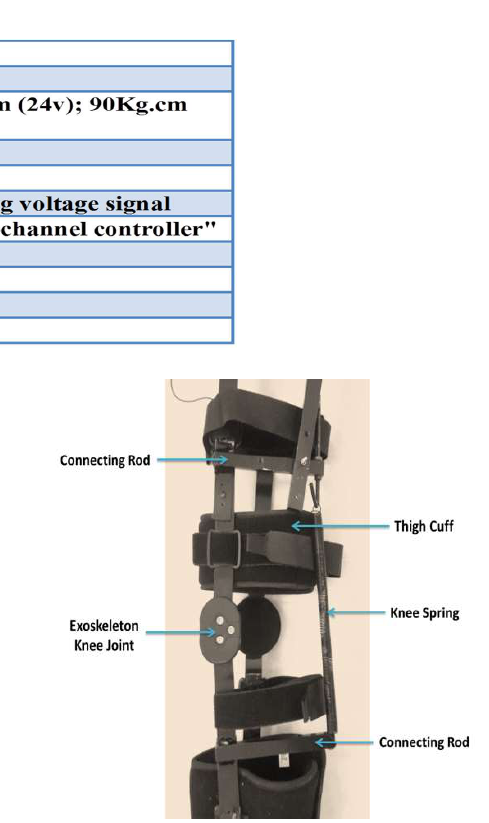
Fig. 9. Exoskeleton knee joint